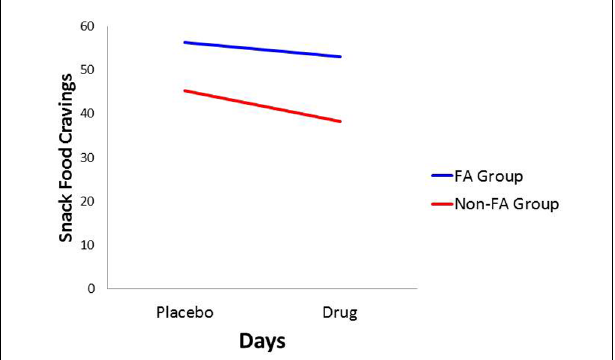
FIGURE 1 | Plot for the Diagnostic Group × Days interaction with food cravings as the dependent